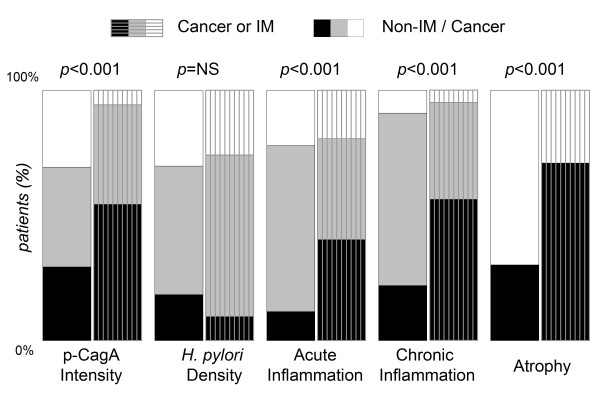
Comparing with the isolates from patients without IM/cancer, those from cancer or IM patients had significantly stronger p-CagA intensity, more gastric atrophy, severer acute or chronic inflammation, but had no difference in H. pylori density. (The black, grey & white bars indicate: strong, weak, & spare p-CagA; dense, moderate & loose H. pylori density; severe, moderate & mild inflammation; with & without atrophy.)